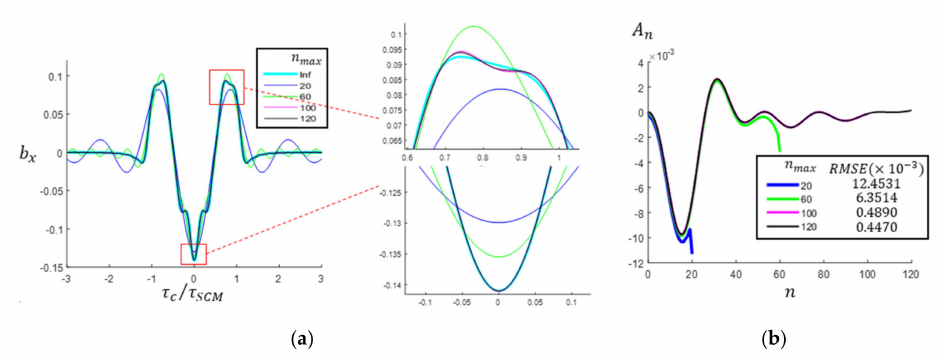
Figure 13. The accuracy for the Fourier series expansion of b x is compared with the various maximum n : ( a ) comparison of the b x values expanded by the Fourier series, ( b ) comparison of the Fourier coe ffi cients and RMSEs.